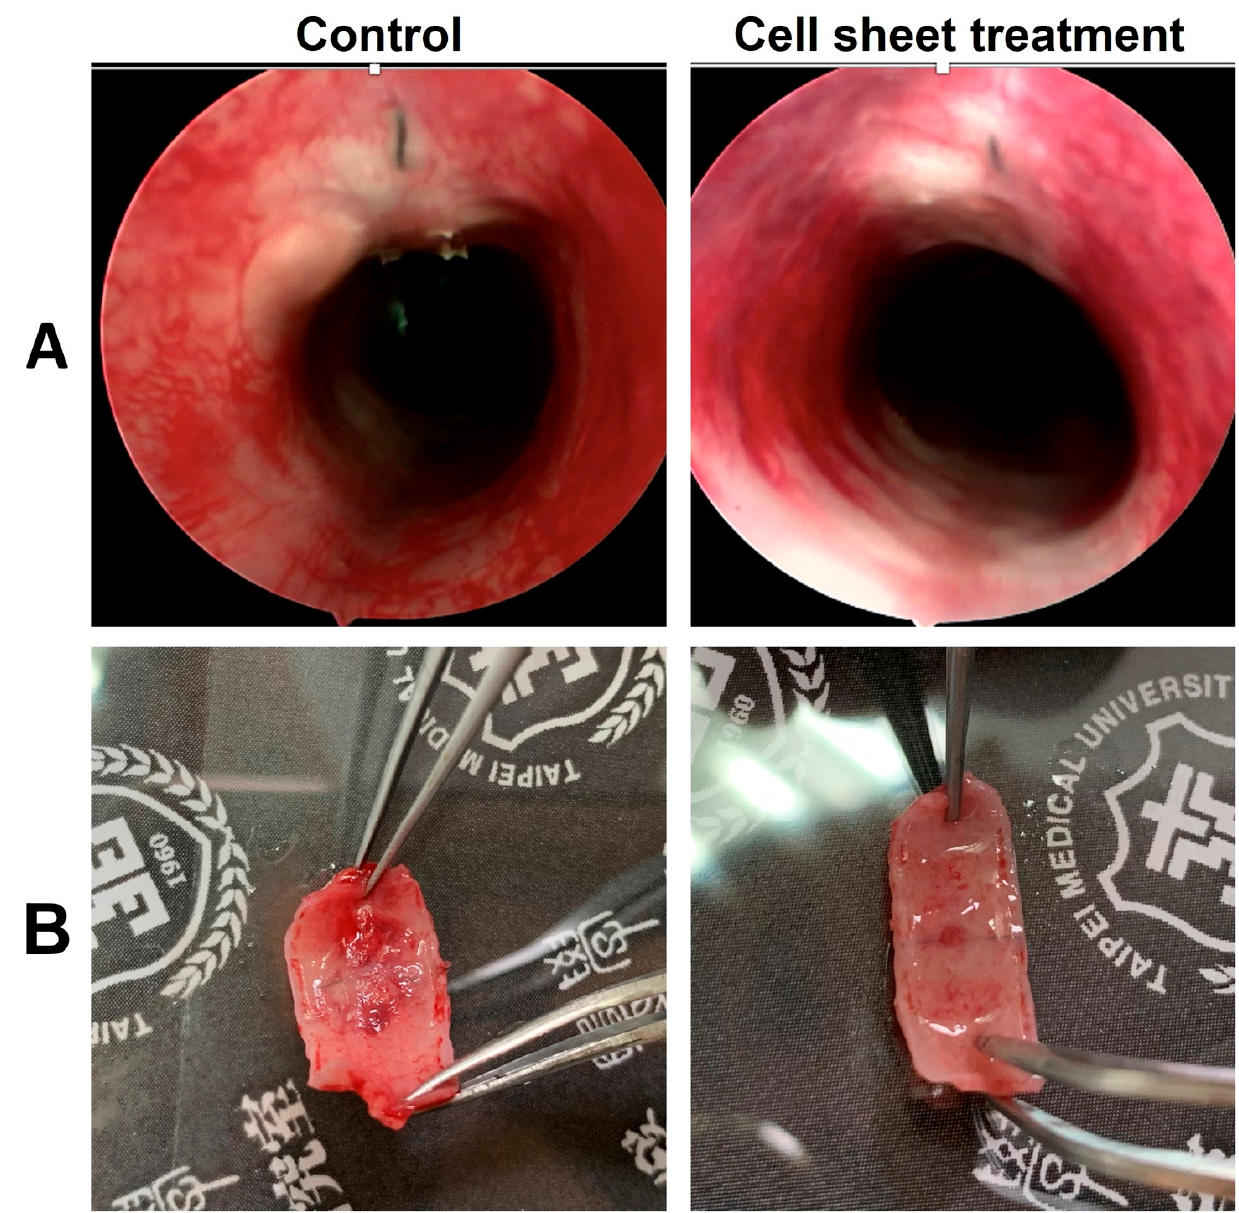
Figure 6. Evaluation of the lumen aspect of the transplanted grafts between two groups. ( A ): Endoscopic view; ( B ): under gross appearance view.